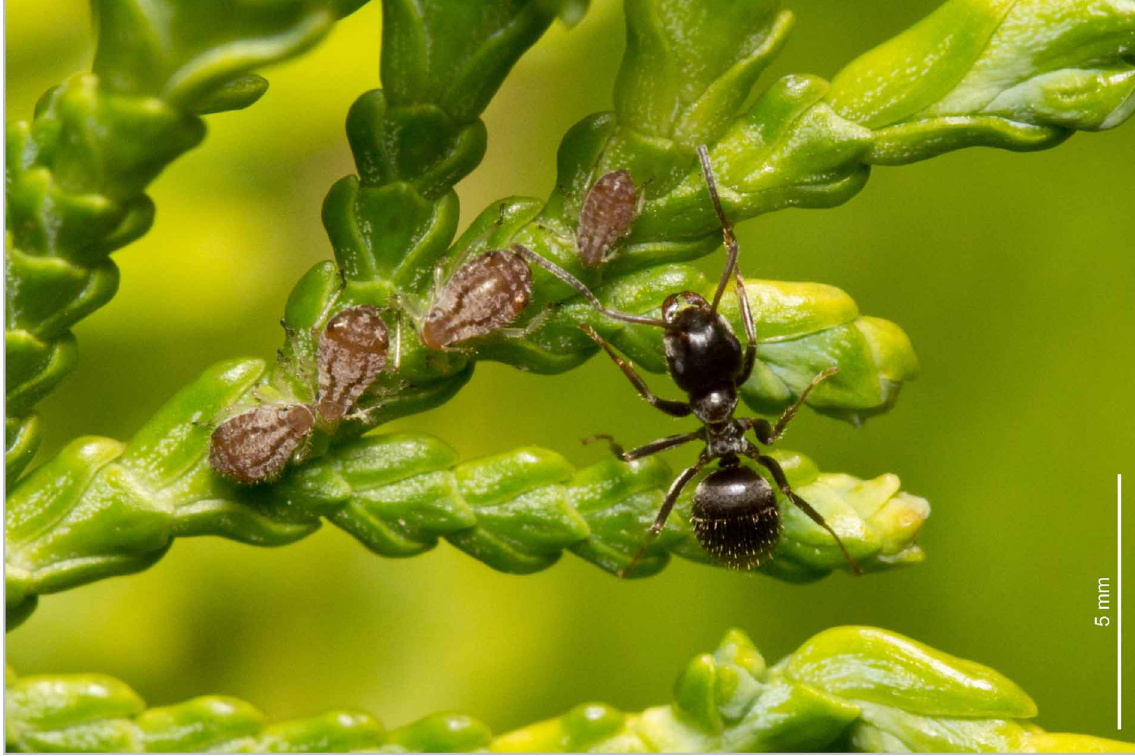
Fig. 118. Cinara (Cupressobium) tujafilina (Del Guercio, 1909) on young growth of Thuja occidentalis , attended by Lasius niger (Linnaeus, 1758). Photo Carlos Delgado (CC BY SA 3.0,